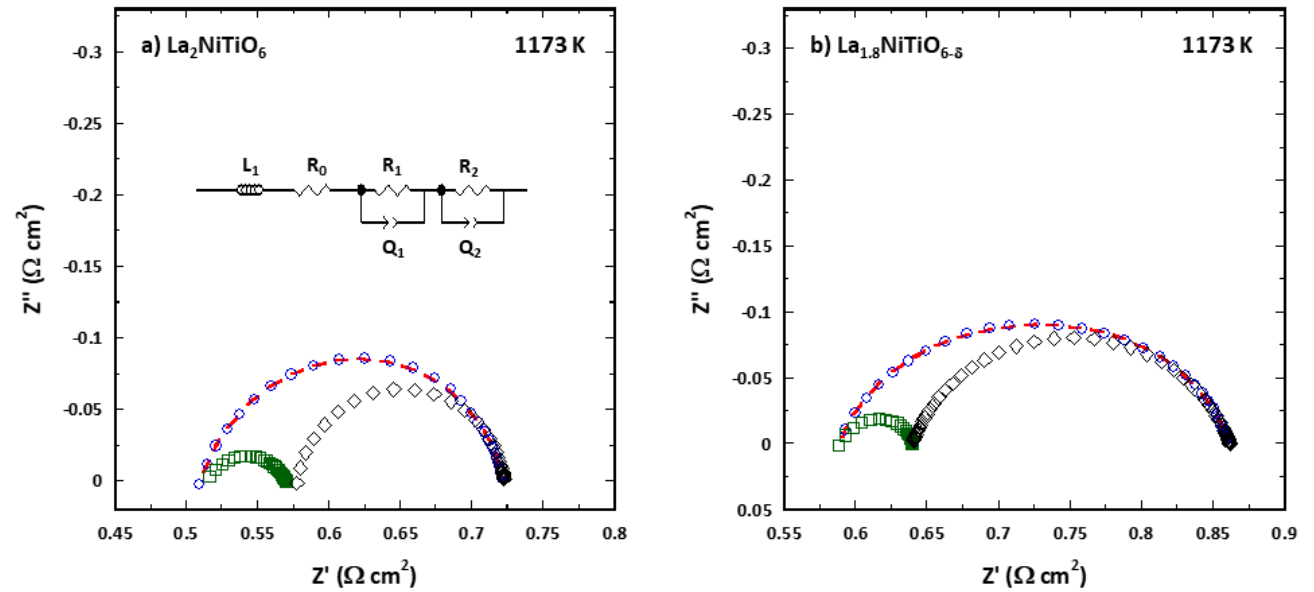
Figure 4. Impedance spectra of La 2 − x NiTiO 6 −δ :YSZ/YSZ/La 2 − x NiTiO 6 −δ :YSZ symmetrical cells for ( a ) x = 0 and ( b ) 0.2, at 1173 K and air atmosphere, fitted to equivalent circuit shown in the inset. Experimental data and fitted spectra are depicted as blue circles and red dotted line, while deconvolution of R 1 Q 1 and R 2 Q 2 elements appears as green squares and black diamonds.